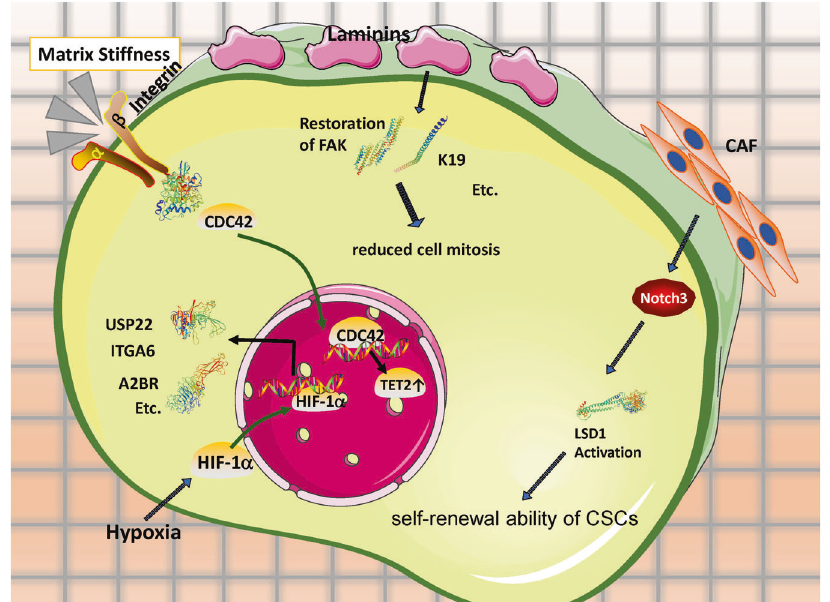
Fig. 1 Quiescent CSCs are responsible for refractoriness to chemotherapies via crosstalk of chemical and mechanical signals from TME components, including hypoxia, ECM, CAFs, and matrix stiffness. Through the utilization of antioxidants and available metabolic substrates, CSCs “ equips ” themselves with metabolic fl exibility to maintain themselves quiescent in response to stress and different metabolic austerity. Crucially, inhibition of the morbidly-activated metabolic pathways on which quiescent CSCs are dependent, show promises on chemotherapy